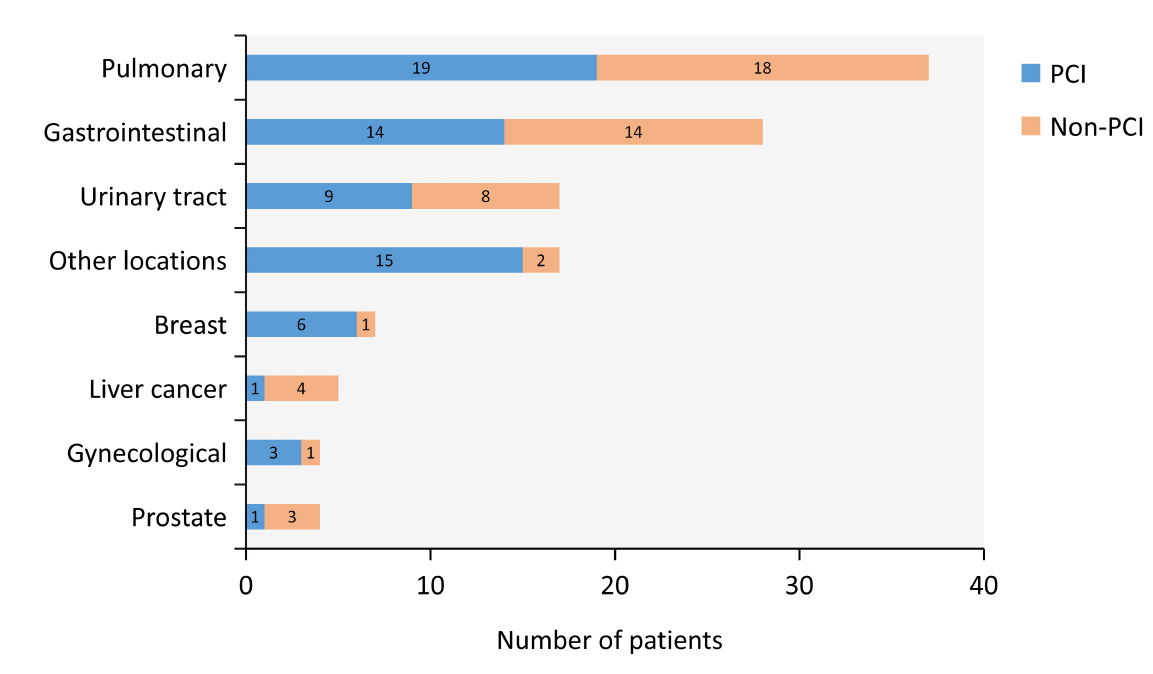
FIGURE2 Type of Cancer. Type of cancer and distribution between percutaneous coronary intervention (PCI) group (blue) and non-PCI group (orange) are shown. Most common cancer types were pulmonary, gastrointestinal, urinary tract, and other